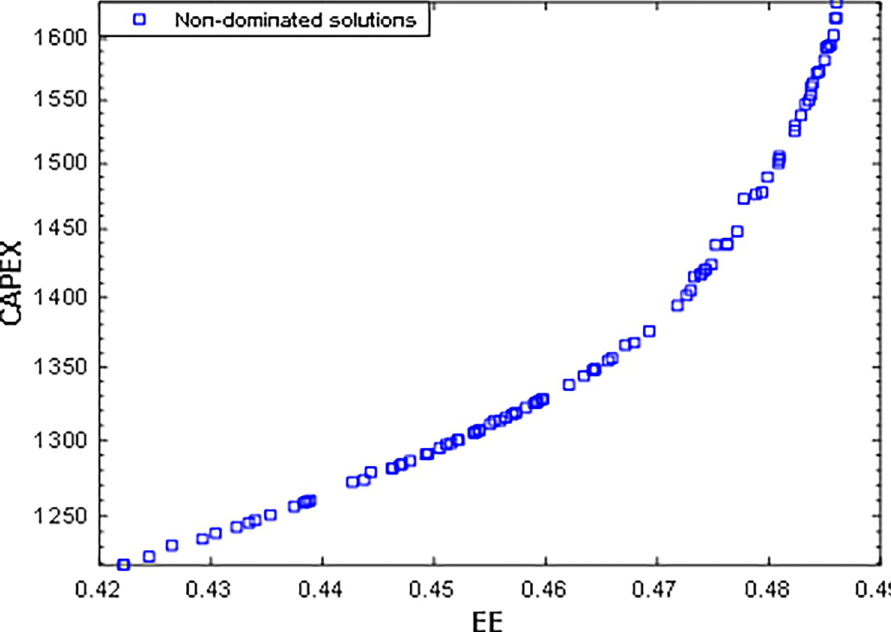
Fig 5. Pareto optimal solutions of the first scenario using